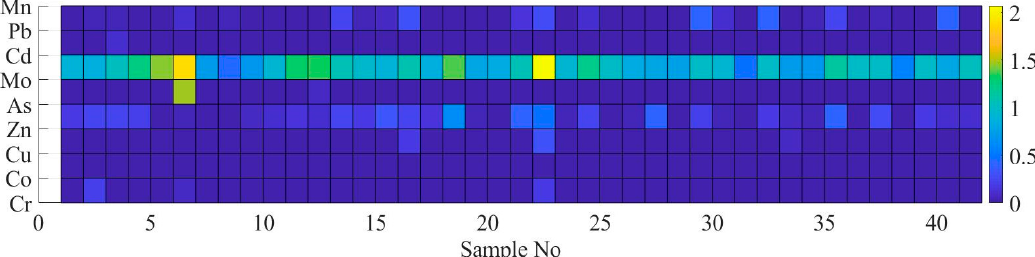
Int. J. Environ. Res. Public Health 2020 , 17 , x Figure 4. Results of enrichment factor (EF) for heavy metals in each sample. Figure 4. Results of enrichment factor (EF) for heavy metals in each sample.